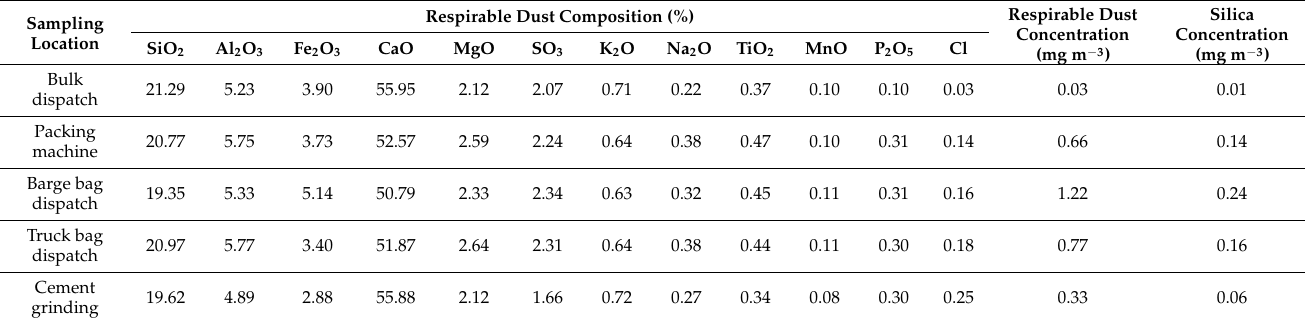
Table 3. The compositions and silica concentrations in the respirable dust